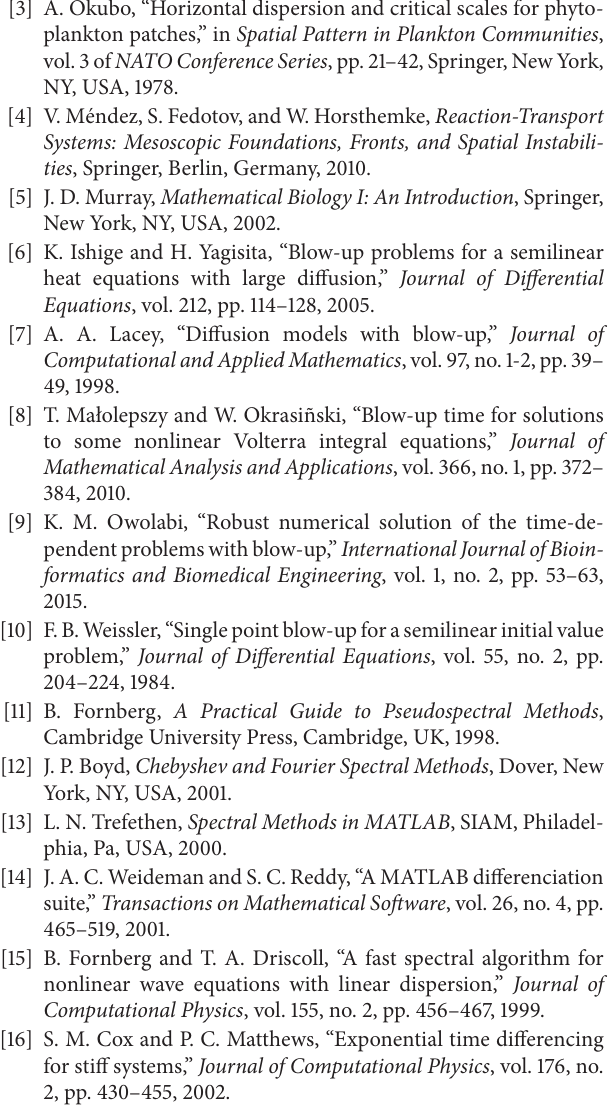
is increasing, so also the isolated species (representing four peaks) spread within the domain to become one. Readers are to compare the results obtained at 𝑡 = 4 in Figures 3 and 4 for